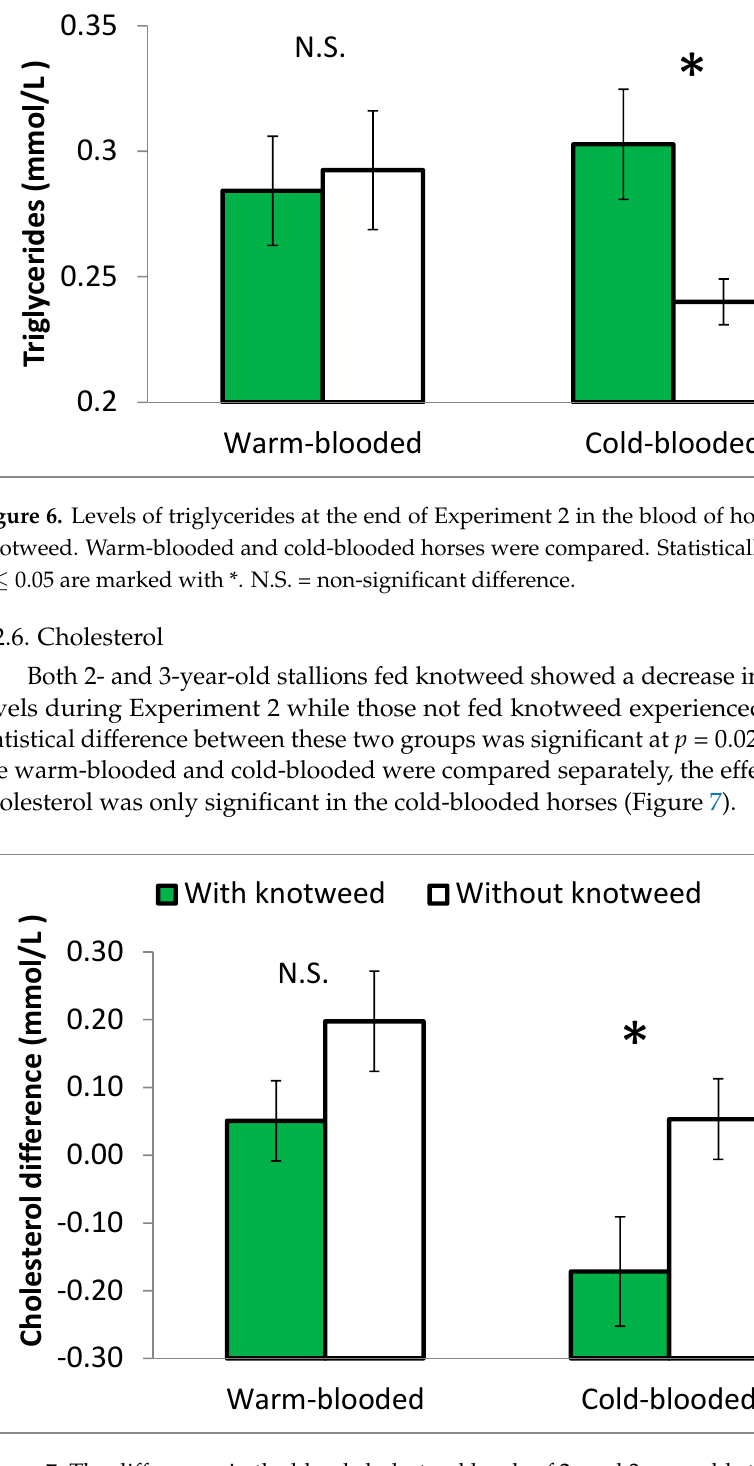
Figure 7. The differences in the blood cholesterol levels of 2- and 3-year-old stallions fed with and without knotweed from the beginning to the end of Experiment 2, comparing warm-blooded and cold-blooded. Statistically different values at p ≤ 0.05 are marked with *. N.S. = non-significant values.